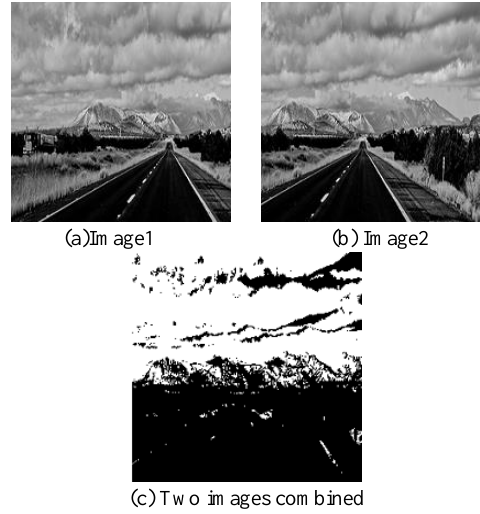
Figure 7. Implementation of two image merging with true two gray